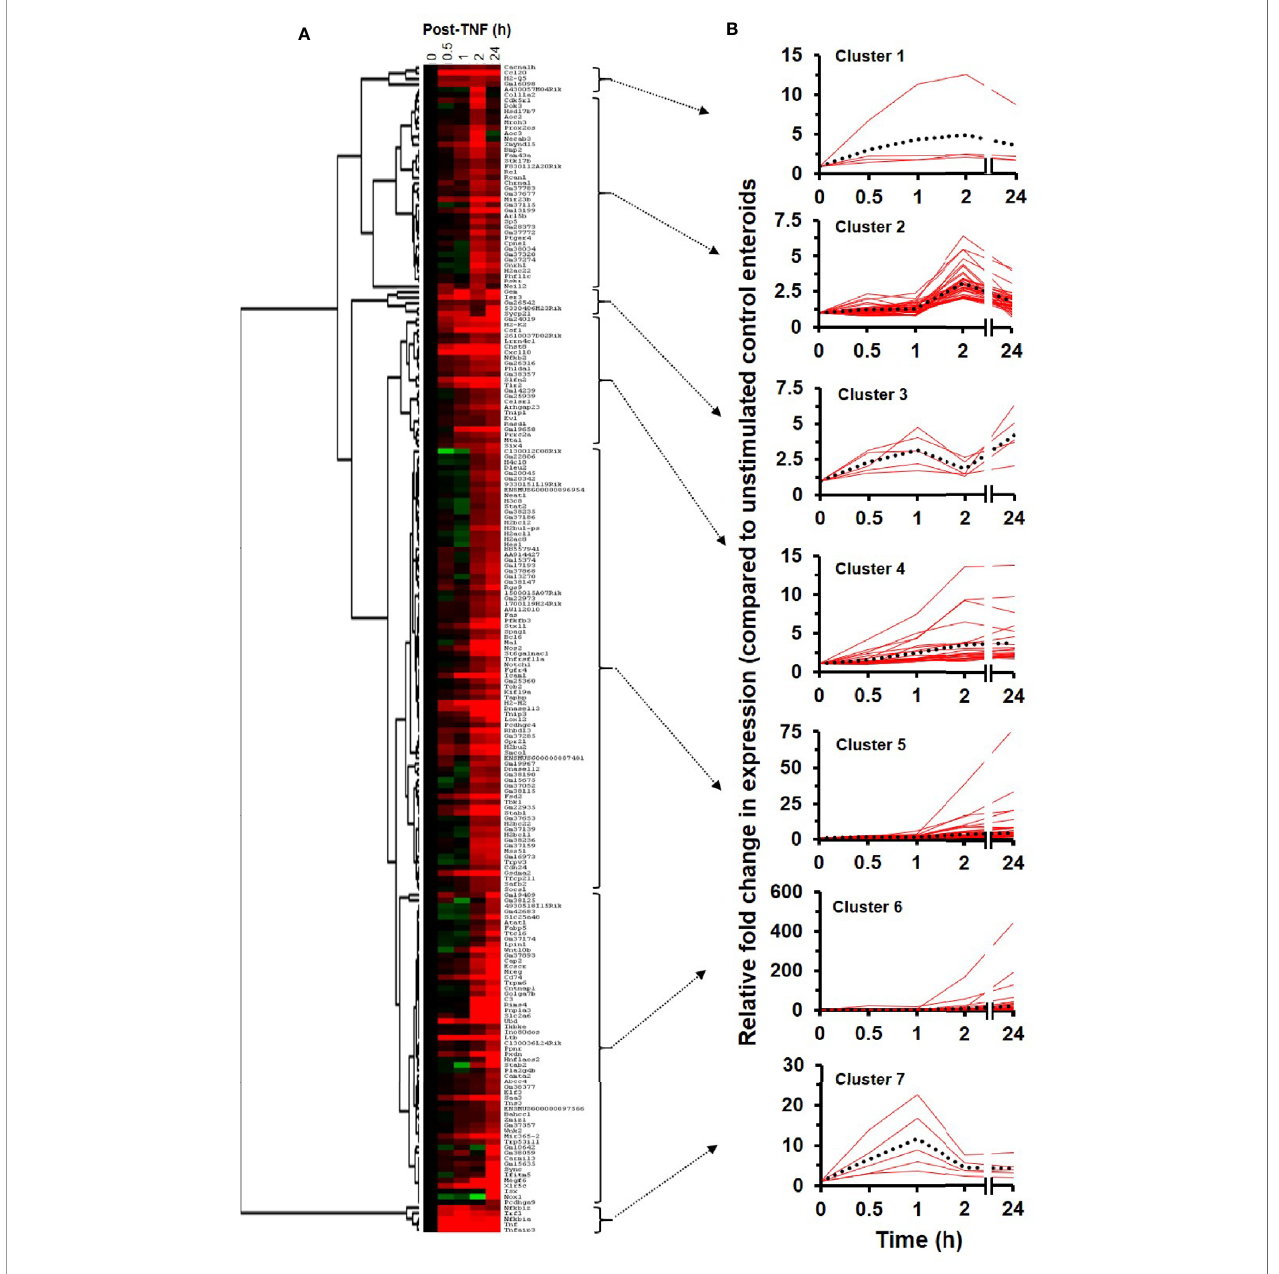
FIGURE 3 | RNA sequencing cluster analysis of TNF-induced enteroids. (A) Heatmap and dendrogram of signi fi cantly altered genes (± two-fold change) at time points 0.5, 1, 2, and 24 h post-treatment with 40 ng/ml TNF compared to unstimulated controls. (B) Cluster correlation analysis identi fi ed seven gene groups (Clusters 1 – 7), with each graph illustrating the dynamic expression pro fi le of individual genes compared to unstimulated controls (0 h). Genes (red lines) are plotted alongside the trend-line (dotted black line) for that cluster so that conformity to the trend can be observed. Data of the relative fold changes to controls for each gene within the clusters are provided in Supplementary Information — Table S2